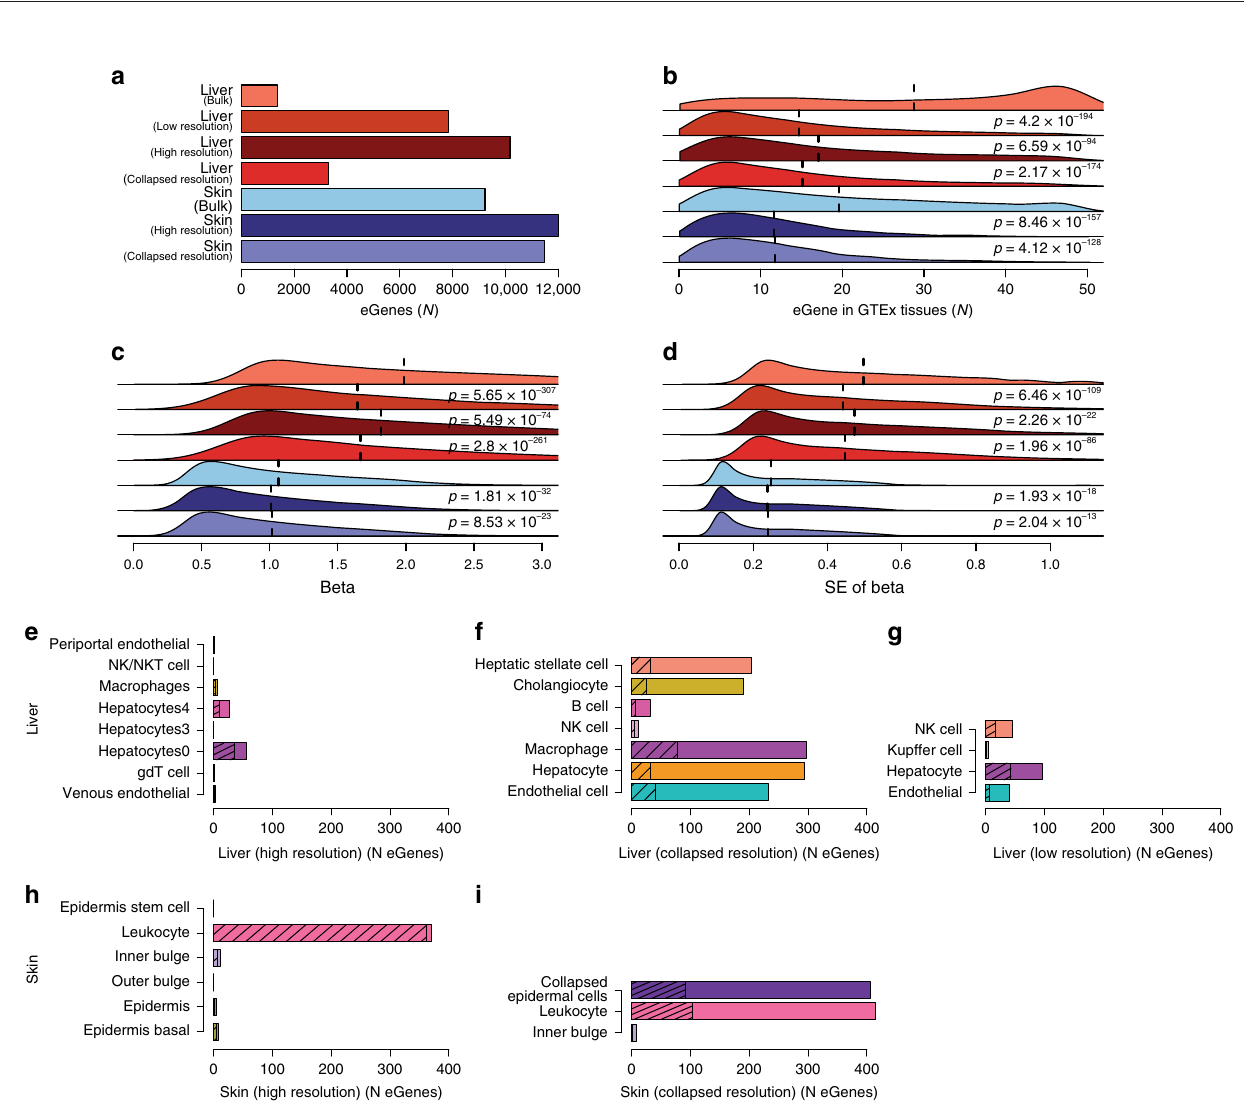
Fig. 4 Cellular deconvolution of 28 GTEx tissues. a UMAP using the expression of all scRNA-seq-derived signature genes across the 28 GTEx tissues. b Stacked bar plots showing the fraction of cell types estimated in GTEx RNA-seq samples from mouse scRNA-seq. A colorblind-friendly version of this fi gure is shown in Supplementary Fig. 5. c Bar plots comparing the number of cell types discovered in mouse scRNA-seq (light gray) vs. the number of these cell types that were estimable for each GTEx tissue. d Box plots showing per RNA-seq sample the distribution of the log 2 average square distance from the mean estimated cellular compositions for each GTEx tissue. The thick, black line indicates the median and the dashed lines indicate the bounds of the upper and lower whiskers.